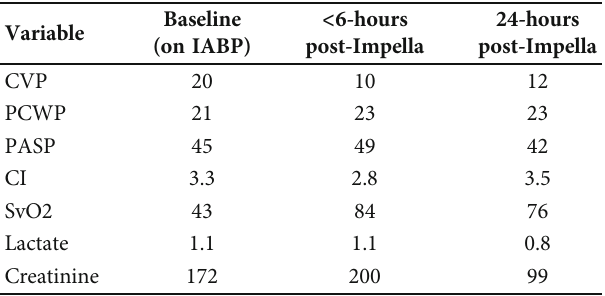
Figure 1: Transthoracic echocardiogram, parasternal long axis view, demonstrating a 1.3cm muscular VSD in the basal anteroseptum ((a), arrow) with left-to-right shunting on colour Doppler (b). Table 1: Haemodynamics and biochemistry pre versus post- Impella insertion demonstrating rapid improvement without increase in right-to-left shunting or right heart